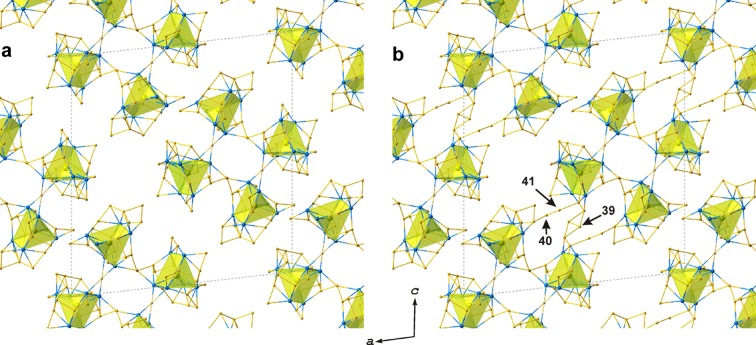
(a) Arrangement of the four-membered rings of the TPTS clusters within the (010) plane and (b) their linkage through additional Si39, Si40 and Si41 nodes into ribbons.